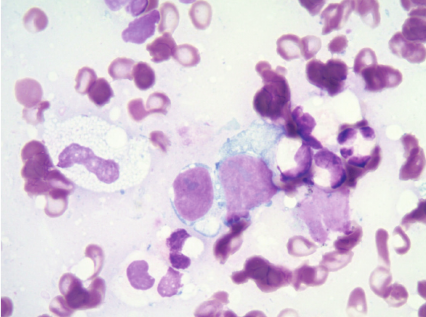
Figure 6: Large cell neuroendocrine carcinoma cytomorphology with moderately abundant pale blue to amphophilic cytoplasm, intermediate to large nuclei, and readily identified nucleoli (Mod- ified Giemsa Stain, Touch Preparation, 1000x).